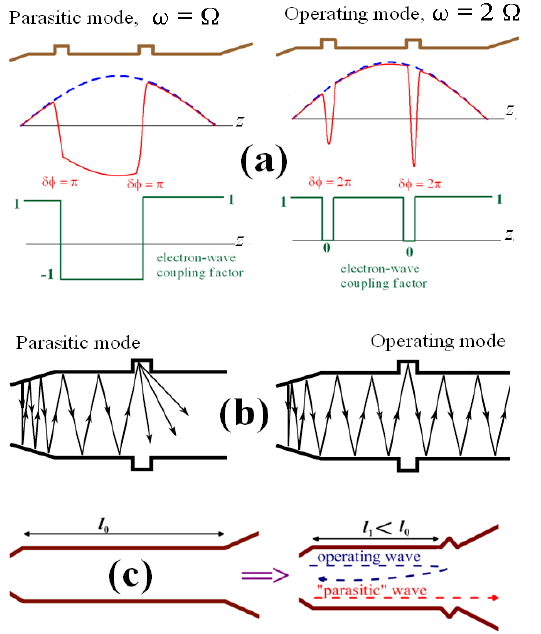
Fig. 3. Gyrotron cavities with selective irregularities. (a): Phase corrector, which provides the 2  phase incursion for the operating second-harmonic wave, and the  phase incur- sion for the parasitic fundamental-harmonic wave. (b): An irregularity providing scattering of the parasitic near-cutoff wave. (c): Shortening of the gyrotron operating cavity by the use of the reflecting output